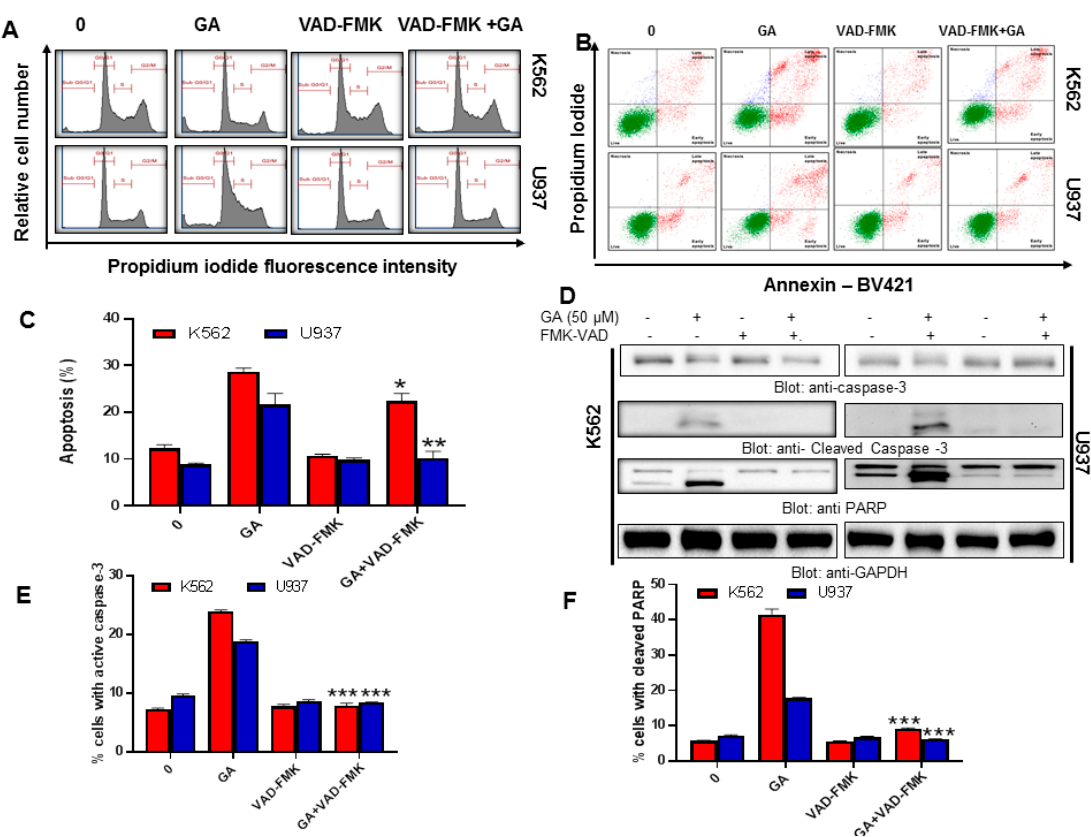
Figure 3. z-VAD-FMK reversed greensporone A-induced cell cycle and caspase activation in leukemic cells. Leukemic cells K562 and U937 cells were treated with greensporone A and z-VAD-FMK alone and in combination for 24 h. ( A , B ) z-VAD-FMK reversed greensporone A-induced increased SubG0 phase and apoptosis, respectively. ( C – E ) Caspase activation induced by greensporone A in K562 and U937 leukemic cells were reversed by z-VAD-FMK as analyzed by western blot and flow cytometry. The graph displays the mean ± SD of three independent experiments. * P < 0.05, ** P < 0.01, *** P < 0.001.